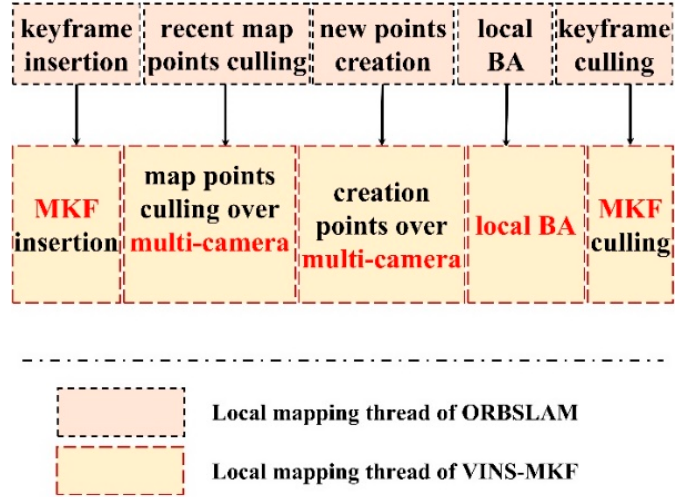
Figure 10. The difference between VINS-MKF and ORBSLAM with regard to the local mapping thread. For VINS-MKF, once the tracking thread spawns a new MKF into the map, the mapping thread updates the co-visibility graph and saves the new MKF’s Bag-of-Words representation. Local mapping also creates new map points between the new MKF and its connected MKFs, removes the outlier map points and MKFs.